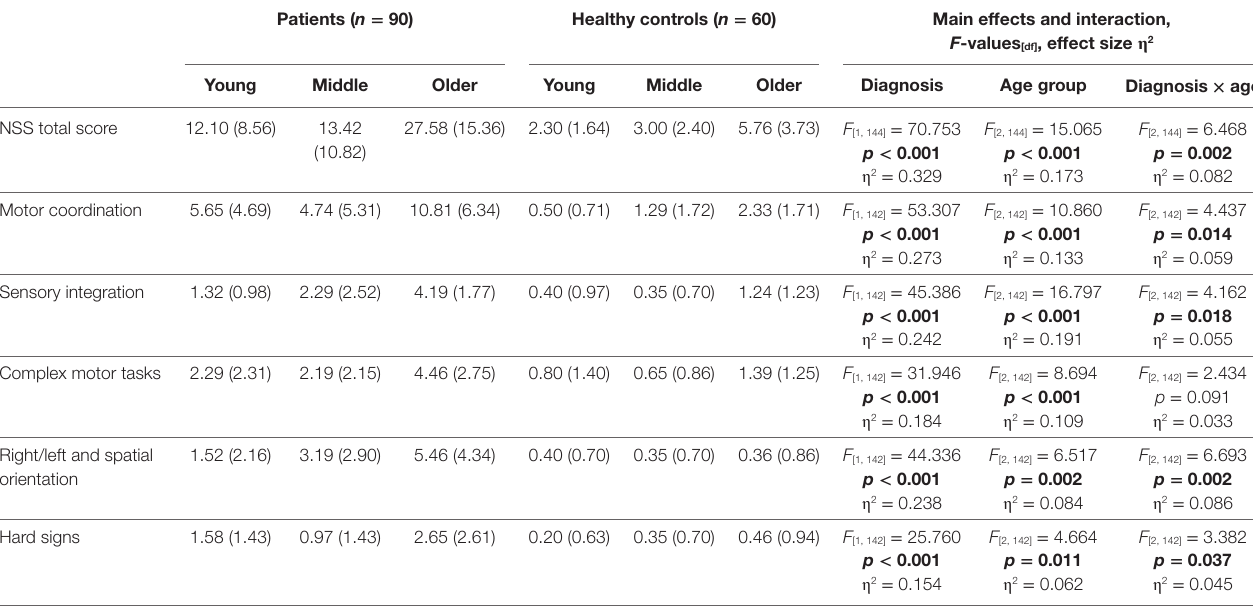
Table 2 | Results of group comparisons on